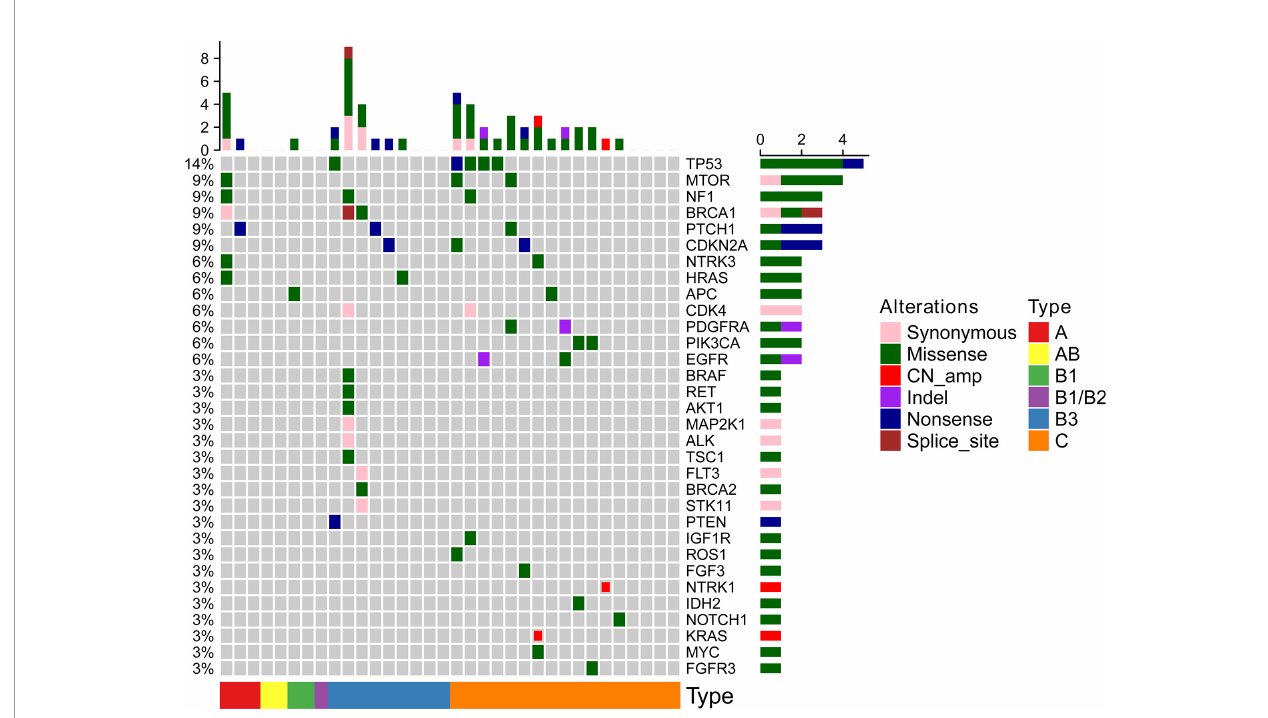
FIGURE 1 | The mutational results of all 34 TETs in our